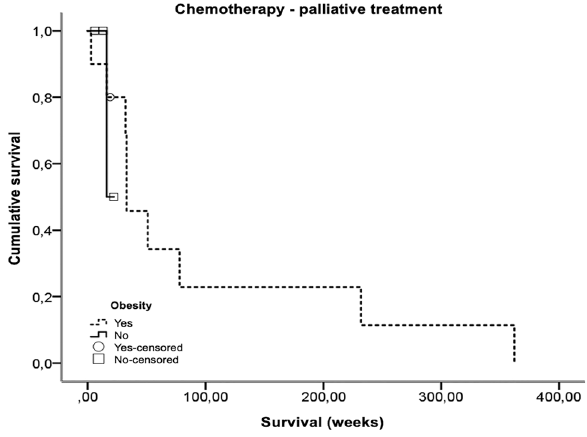
Figure 11. Survival curve, in the Kaplan-Meier assessment, relating obesity to survival, among patients undergoing chemotherapy, with palliative treatment intent. Non-obese: mean of 95.73 weeks; Obese: mean of 19.00 weeks (Kaplan-Meier test – log-rank/Mantel-Cox: